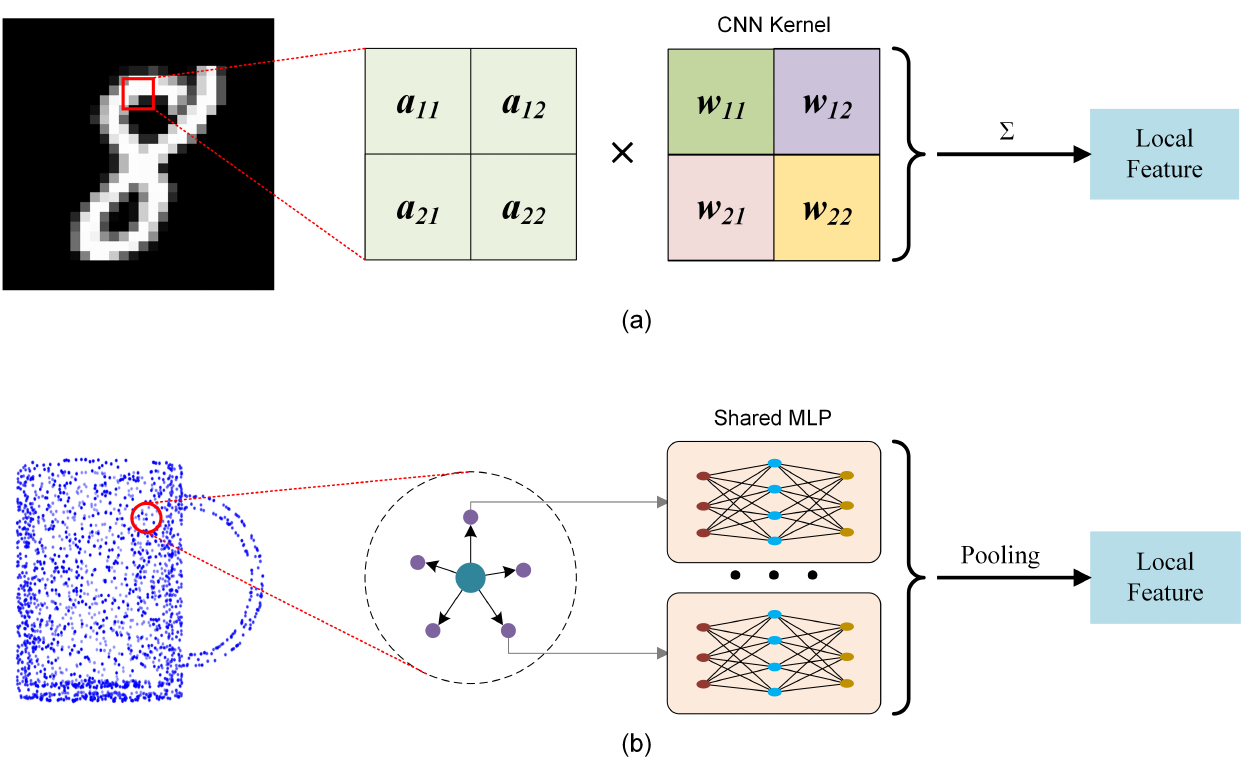
Figure 1. Two local feature extraction methods: ( a ) The convolution kernel provides different weights for input features at different locations, potentially encoding the spatial distribution information of the input features; ( b ) Points at different locations share the same MLP feature extractor, so shared MLP ignores the spatial distribution